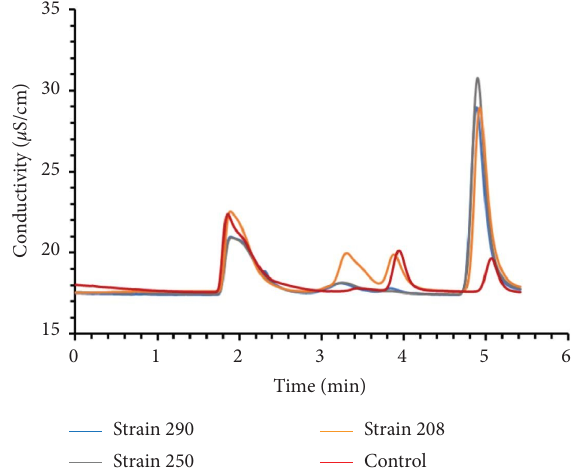
Figure 5: Ion exchange chromatogram for the culture media supernatant containing the selected strains (208, 250, and 290) and culture media with no bacterial exposure as control.